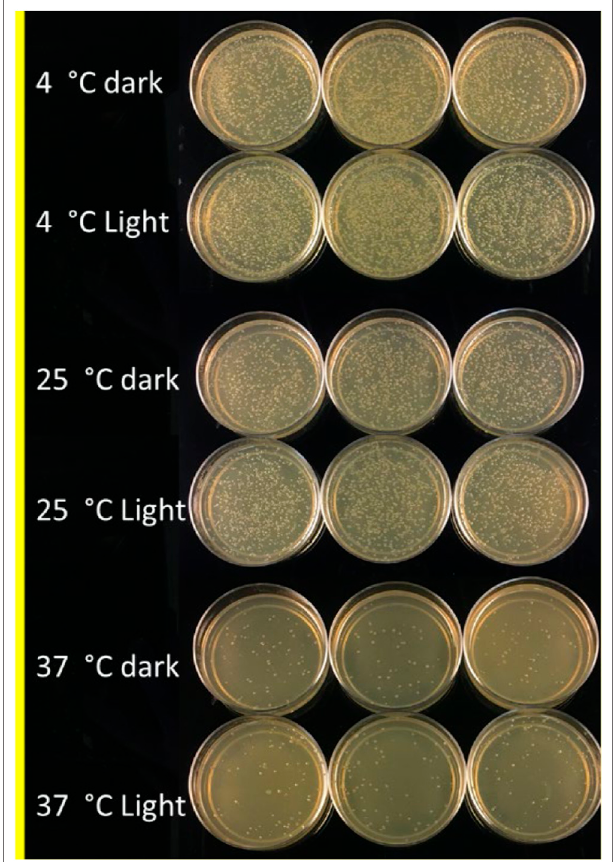
FIGURE 6 | LB-plates with transformed colonies of E. coli after incubation at 4 ° C, 25 ° C, and 37 ° C in light and dark conditions using